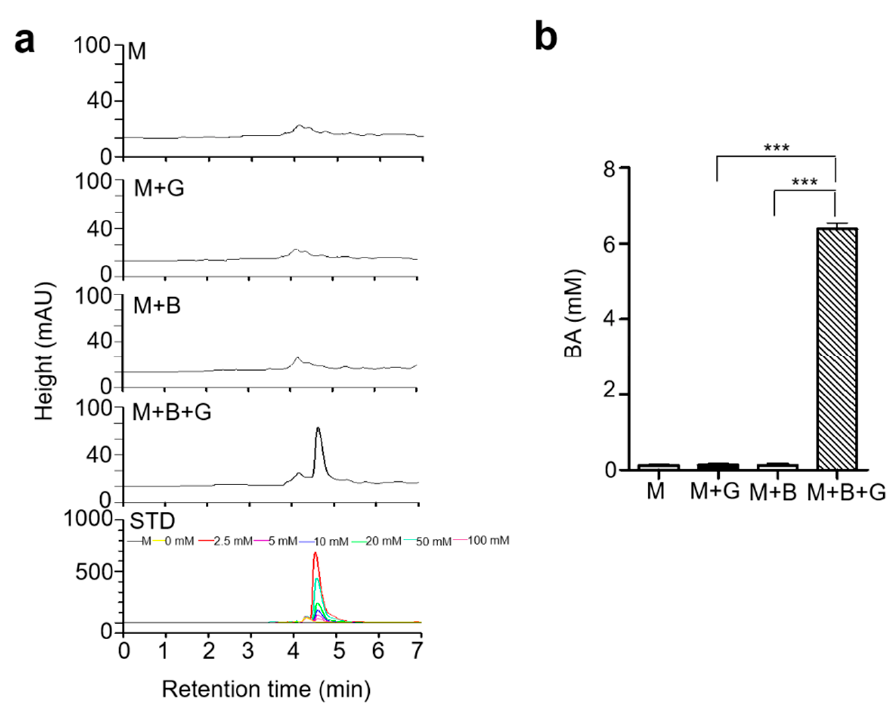
Figure 2. High-performance liquid chromatography-ultraviolet (HPLC-UV) analysis of the butyric acid. The fermented media from glycerol (G) fermentation by S. epidermidis bacteria (B) analyzed by HPLC. ( a ) Chromatograph of only media (M), media with glycerol (M + G), media with bacteria (M + B), and media with bacteria plus glycerol (M + B + G). The x-axis is retention time in minutes, and the y-axis is the milli-absorbance unit at 210 nm. ( b ) The concentrations of BA (butyric acid) was quantified from the height of butyric acid standard (STD) peaks. Data shown represent the mean ± SE of experiment performed in triplicate. *** p < 0.0001 (two-tailed t -test).